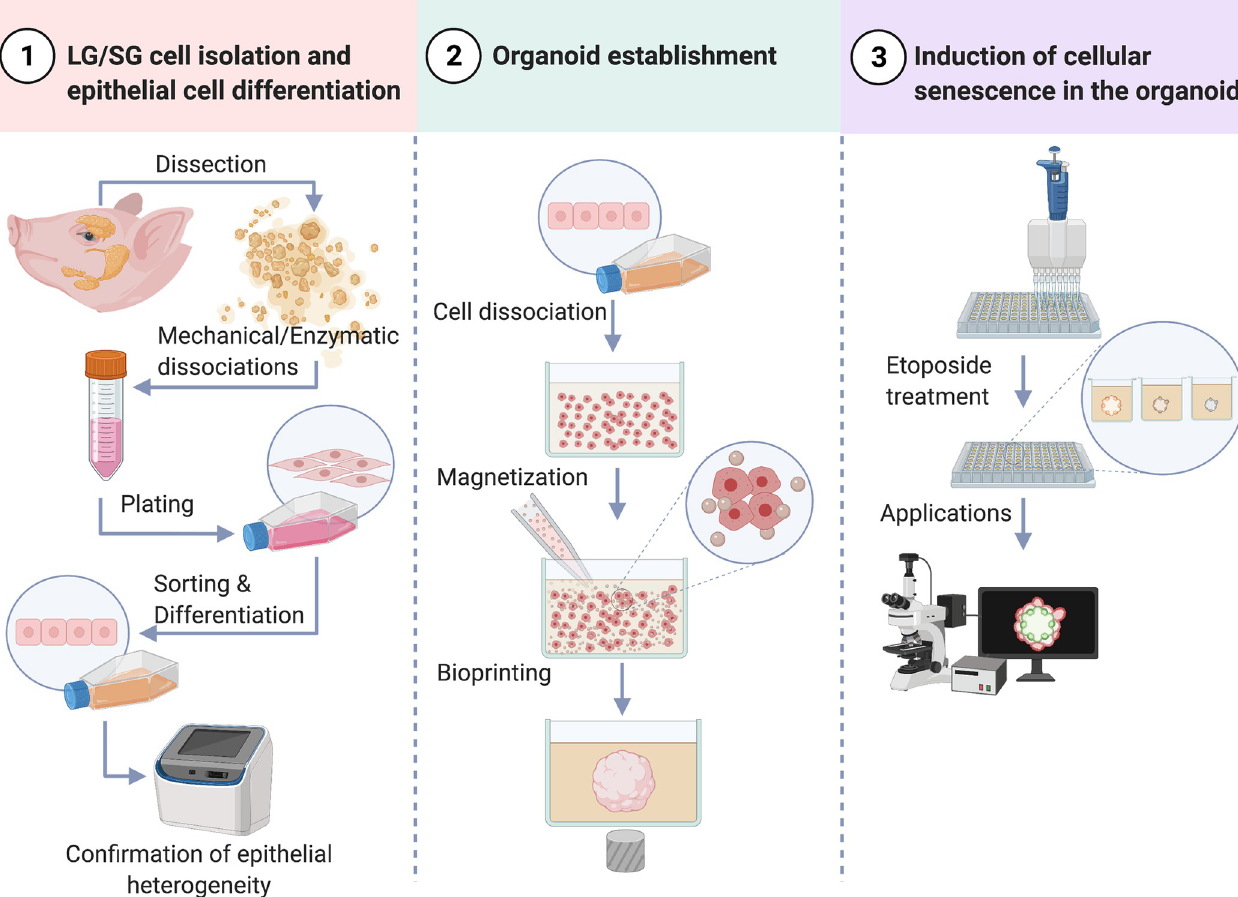
Fig 1. Lab protocols for lacrimal gland (LG) and salivary gland (SG) organoid biofabrication via M3DB and induction of cellular senescence. Created with